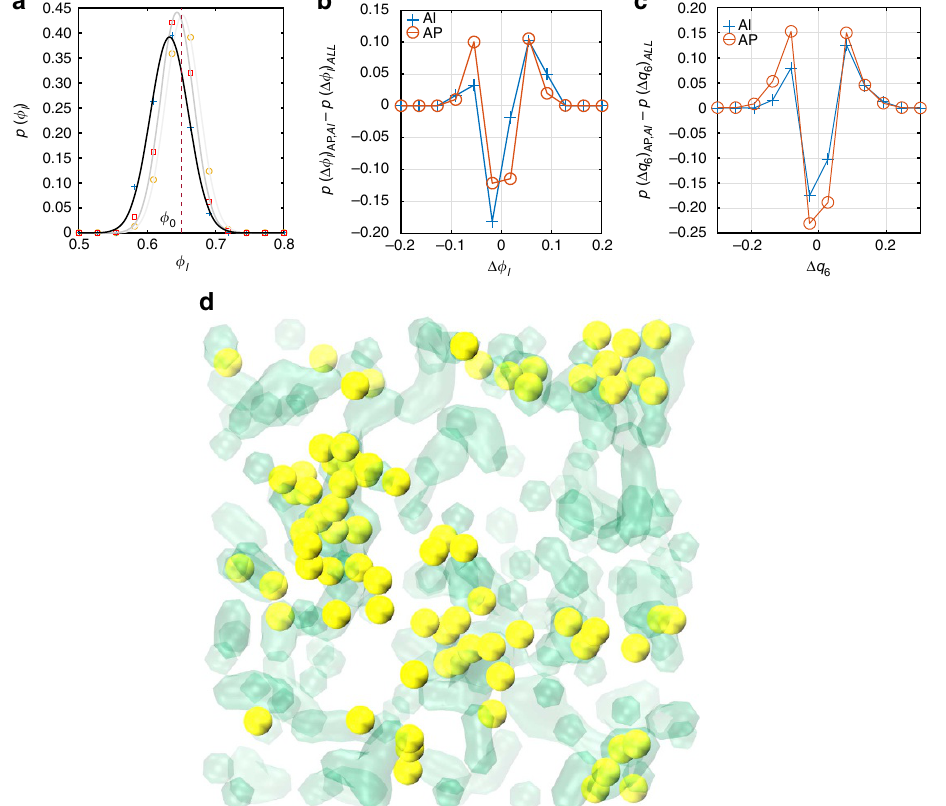
Figure 4 | Iso-configurational ensemble. Analysis of 38 events found in 100 iso-configurational trajectories for the monodisperse case ( f ¼ 0.65). The initial state is taken from one of the MSD plateaux in the original 50 independent runs. ( a ) Local Voronoi density distribution for AIs, APs and all particles, and differences between all-particle probability distributions and AI, AP distributions for changes in ( b ) local density f l and ( c ) BOO parameter q 6 . Data is given for the monodisperse set. Note that all prominent features of the independent runs are replicated, including a lower initial local density and marked asymmetry in structural change for AIs, and not for APs. ( d ) A map of all unique AIs (yellow) from the detected events and regions (transparent